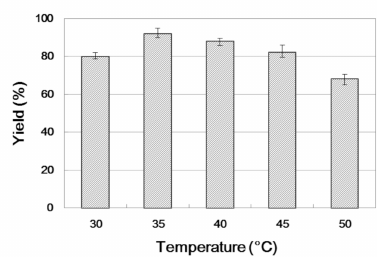
Figure 2. The influence of temperature on the enzymatic synthesis of β -amino alcohol 3a under continuous-flow